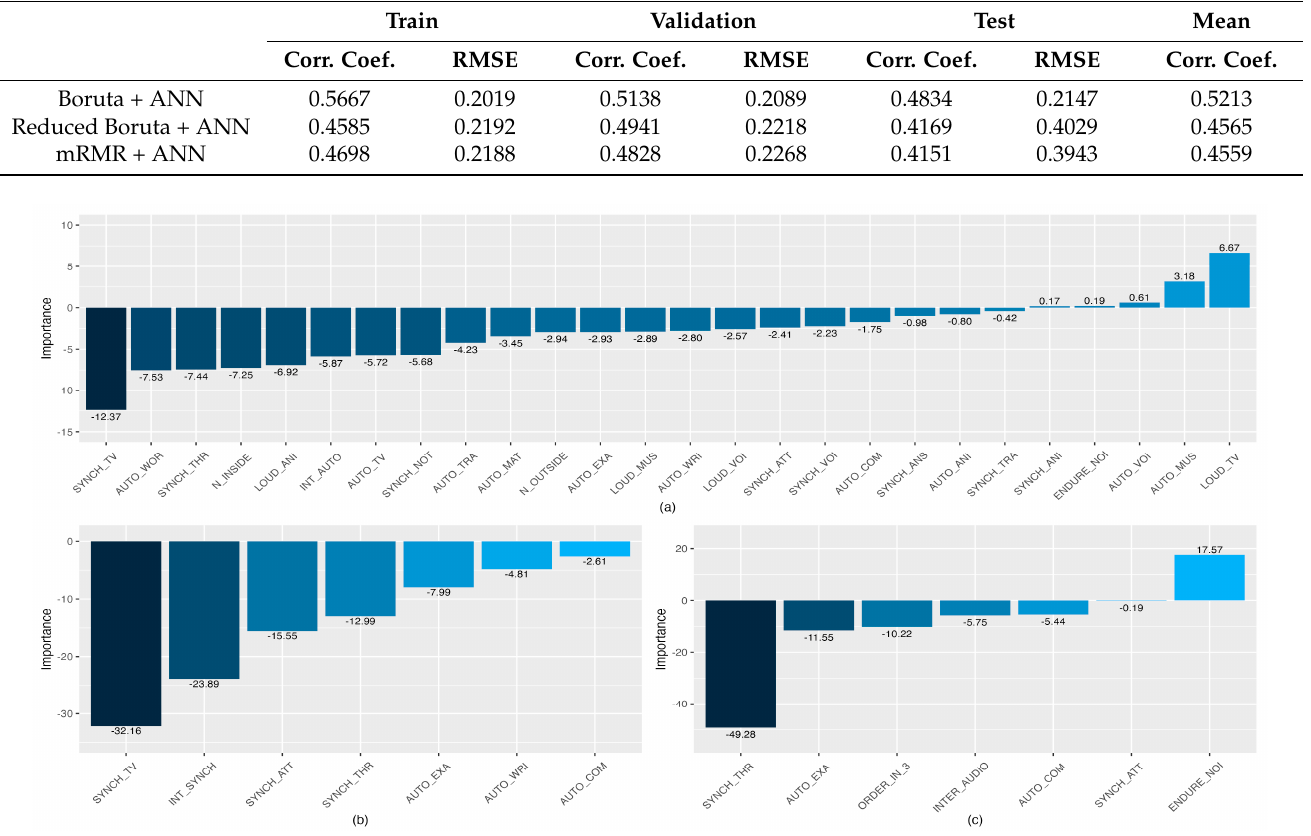
Table 3. ANN results for the best-performing models (among 100) for students’ satisfaction with the online teaching method, using the variables selected by Boruta and mRMR, and the set of reduced Boruta. The table shows the correlation coefficient and the root mean square error (RMSE) for the train, test, and validation sets.